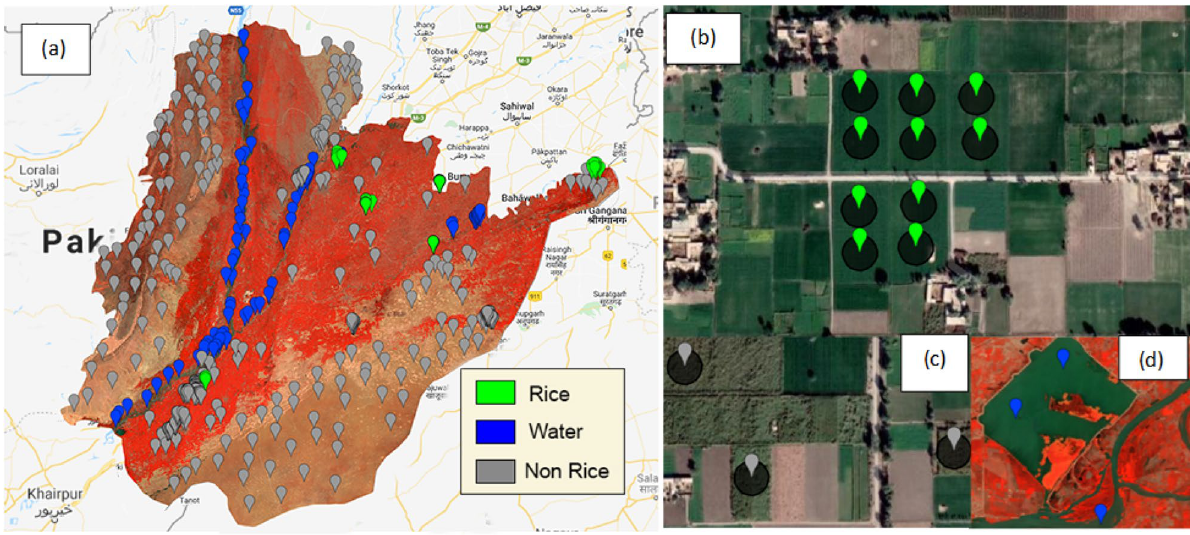
Figure 6. Training samples in the study area, ( a ) all samples, ( b ) ricefield samples, ( c ) non-rice samples, and ( d ) water samples. The map is designed in Google Earth Engine, which is an cloud computing browser based platform (https:// earth engine. google. com).